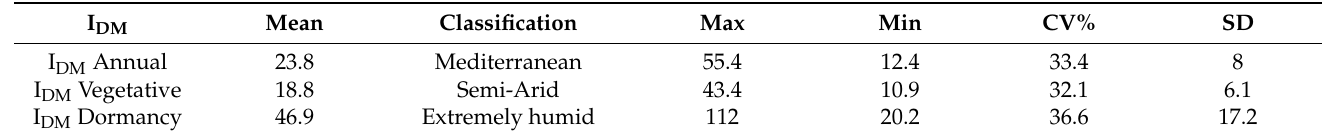
Table 2. Descriptive statistics of the De Martonne index in Extremadura for the annual, vegetative, and dormancy periods (1989–2020).